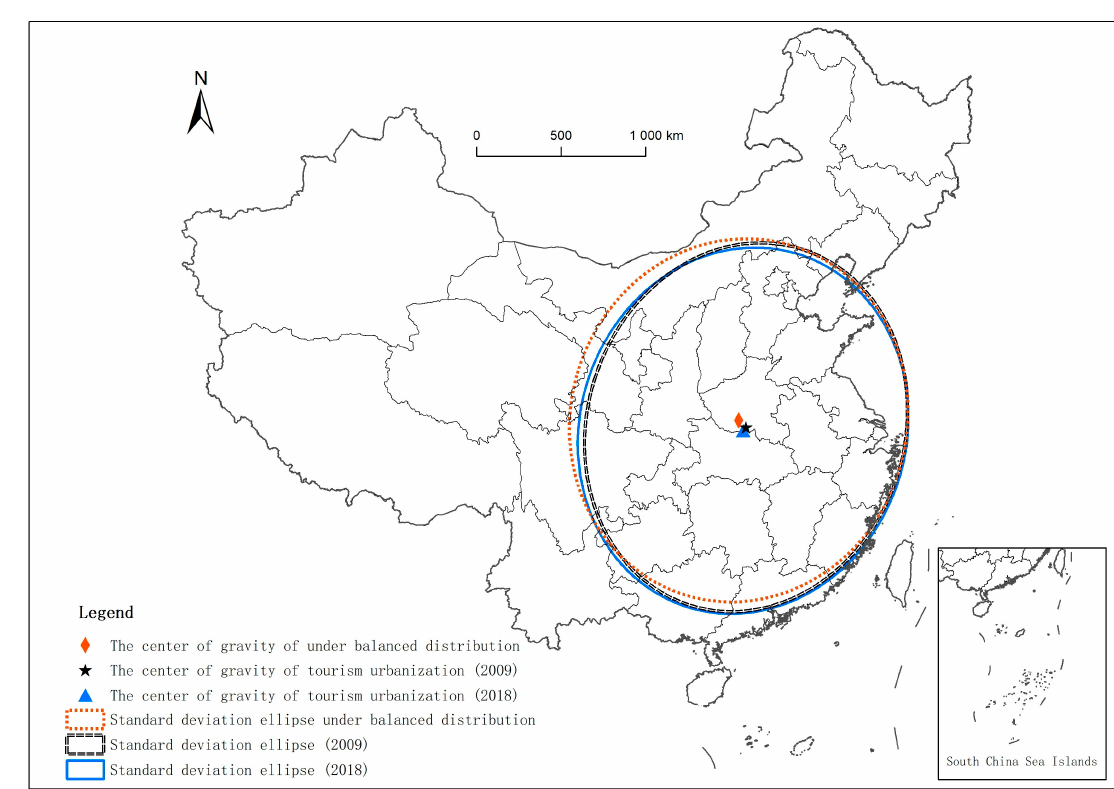
Figure 6. Standard deviation ellipse of tourism urbanization in major tourist cities in China.